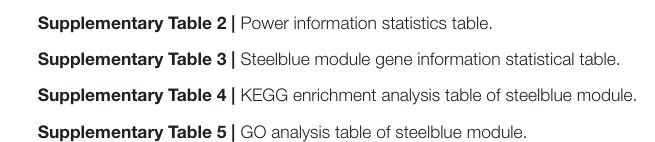
Supplementary Table 1 | Primer sequences of candidate gene and reference genes. Supplementary Table 2 | Power information statistics table. Supplementary Table 3 | Steelblue module gene information statistical table. Supplementary Table 4 | KEGG enrichment analysis table of steelblue module. Supplementary Table 5 | GO analysis table of steelblue